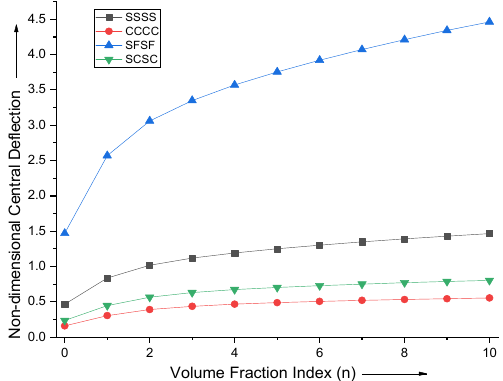
deflection is maximum for the simply supported free boundary condition and it is minimum mum for the all sides clamped condition. for the all sides clamped condition.